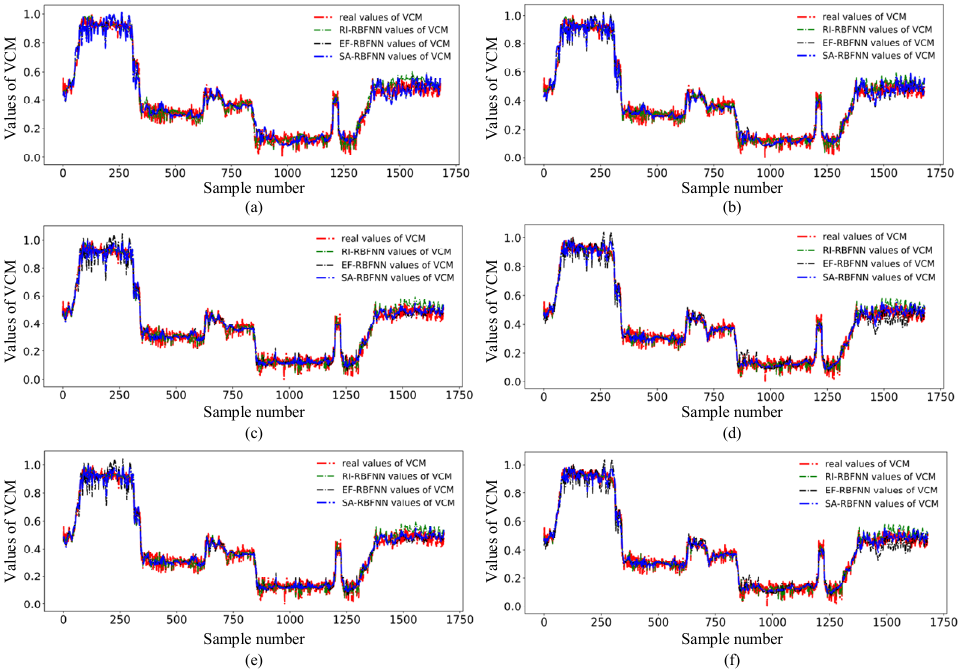
Figure 5. Soft sensing results of VCM using three RBFNN based methods under different cluster number ( a ) 15 clusters ( b ) 20 clusters ( c ) 25 clusters ( d ) 30 clusters ( e ) 35 clusters ( f ) 40 clusters. In Figure 5, the red dashed lines are the real values, while the green, black and blue dashed lines are the predicted values from RI-RBFNN, EF-RBFNN and